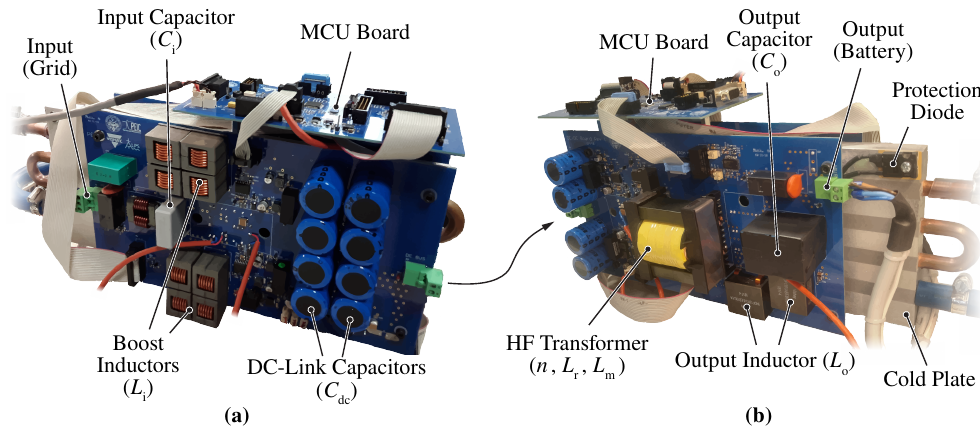
Figure 12. View of the 3.3kW OBC prototype under test: ( a ) PFC stage and ( b ) DC/DC